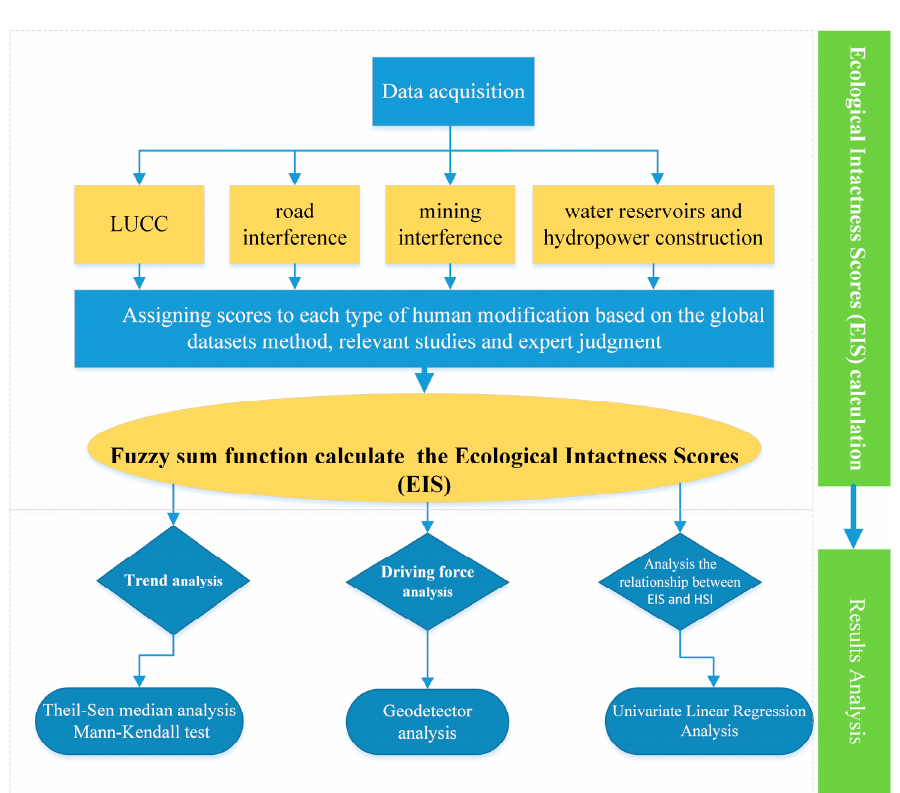
Figure 2. Flow chart of EIS calculation and technical framework of this study.